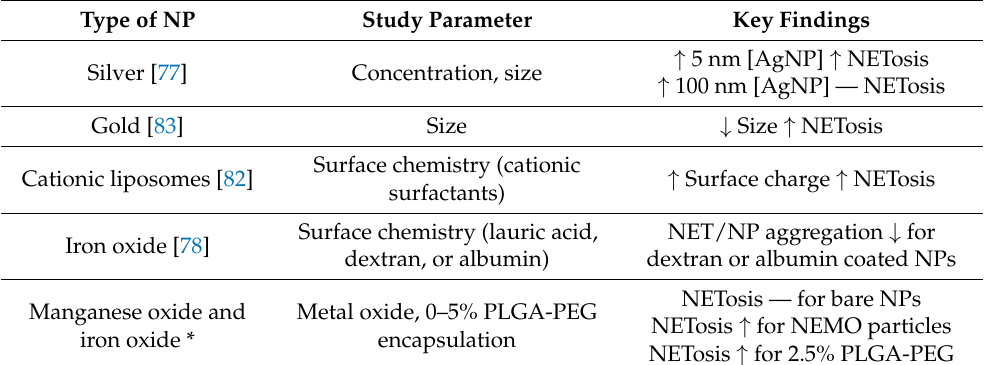
Table 3. A summary of the literature examining how engineering NP characteristics impacts NETosis. Type of NP Study Parameter Key Findings ↑ 5 nm [AgNP] ↑ NETosis Silver [77] Concentration, size ↑ 100 nm [AgNP] — NETosis Gold [83] Size ↓ Size ↑ NETosis Surface chemistry (cationic ↑ Surface charge ↑ NETosis Cationic liposomes [82] surfactants) Surface chemistry (lauric acid, NET/NP aggregation ↓ for Iron oxide [78] dextran, or albumin) dextran or albumin coated NPs NETosis — for bare NPs Manganese oxide and Metal oxide, 0–5% PLGA-PEG NETosis ↑ for NEMO particles iron oxide * encapsulation NETosis ↑ for 2.5% PLGA-PEG ↑ indicates increase, — indicates no effect relative to control, ↓ indicates decrease, * indicates this